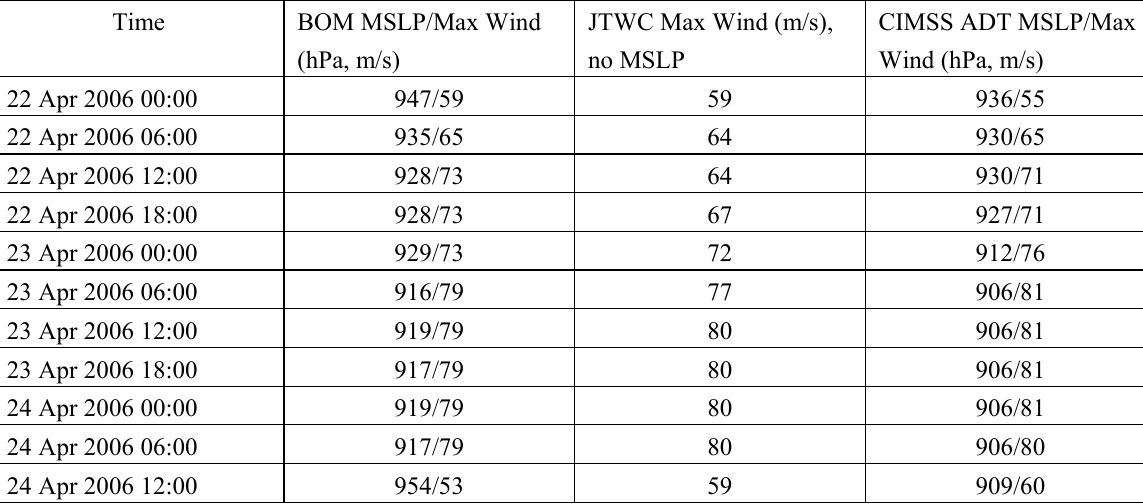
Table 1 . Intensity estimates versus time for BOM, JTWC, and CIMSS. BOM 10-minute average maximum wind speeds were converted to 1-minute average using a multiplying factor of 1.14. Estimates have been interpolated to standard times for comparison.